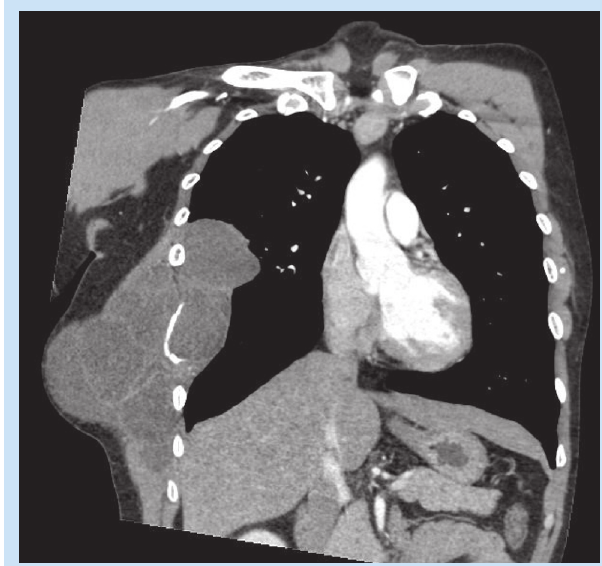
Fig. 1. CT coronal reconstruction.